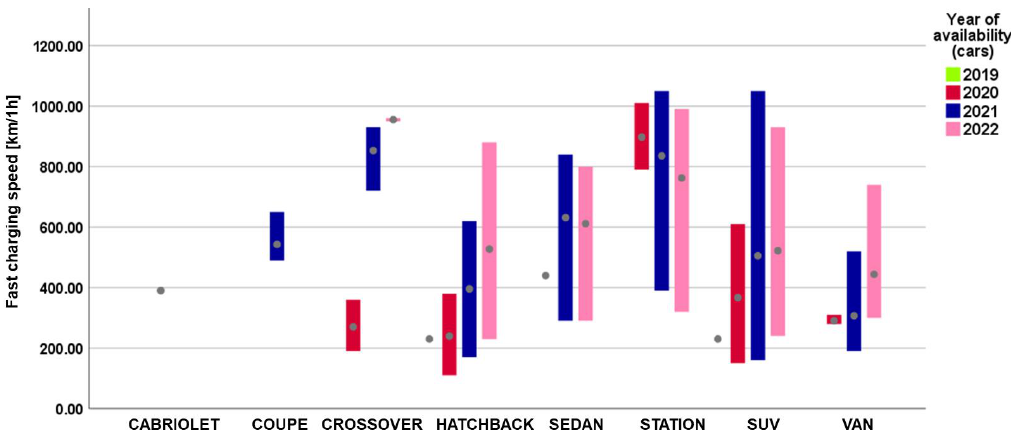
Figure 18. Range bar variation (min, max, mean) representation of fast charging speed vs. type of cars.